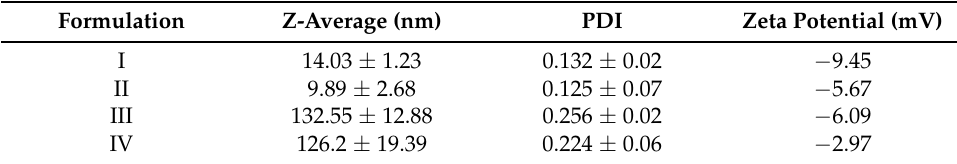
Table 2. Particle size (Z-average (nm)), PDI, and zeta potential (mV) of formulations (mean ± SD, n = 3).